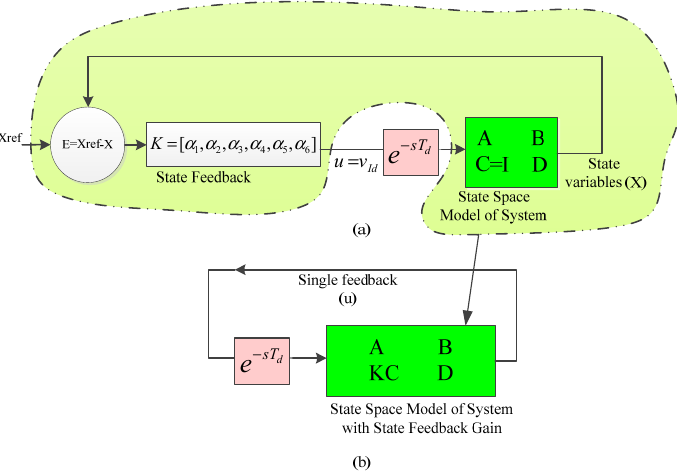
Figure 6. Converting a state feedback loop ( a ) to a single output feedback loop ( b ).